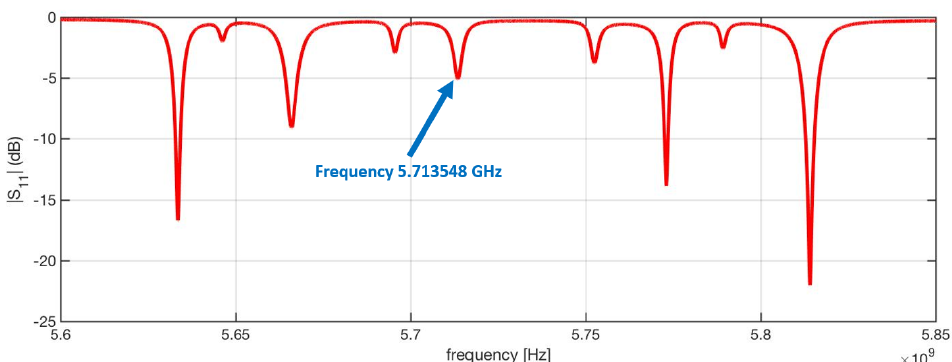
Figure 8. Reflection coefficient S11 in dB before the tuning